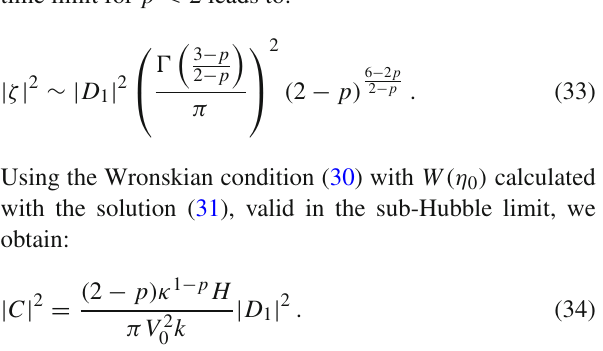
Fig. 2 Enhancement of the power spectrum of curvature perturbations predicted by Eq. (35)